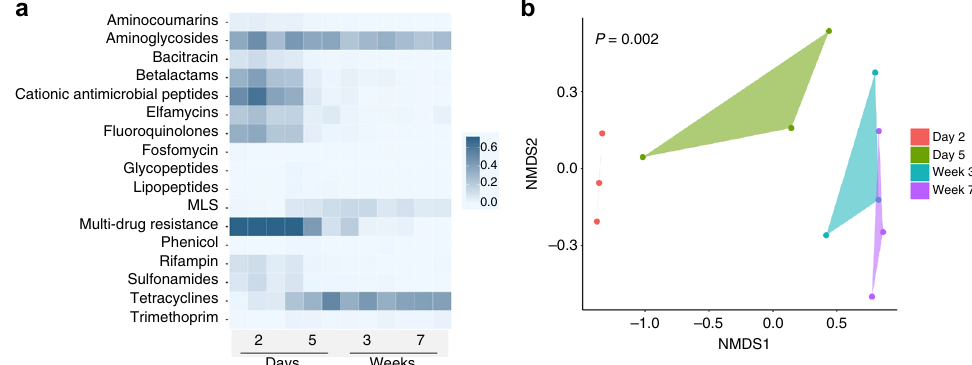
Fig. 2 The fecal resistome structure of dairy calves over time. ( a ) Dairy calf fecal samples exhibited a broad antibiotic resistance spectrum including resistance to 17 classes of antibiotics. The counts data were normalized by 16S rRNA gene and the ARG abundance was expressed as “ copy of ARG per copy of 16S rRNA gene ” (see Methods). b 2-dimensional NMDS of calf resistome based on a Bray-Curtis dissimilarity calculation (stress = 0.02), showing changes in resistome structure over time assessed by PERMANOVA. Polygons were applied to group samples at the same time point. Source data are provided as a Source Data fi